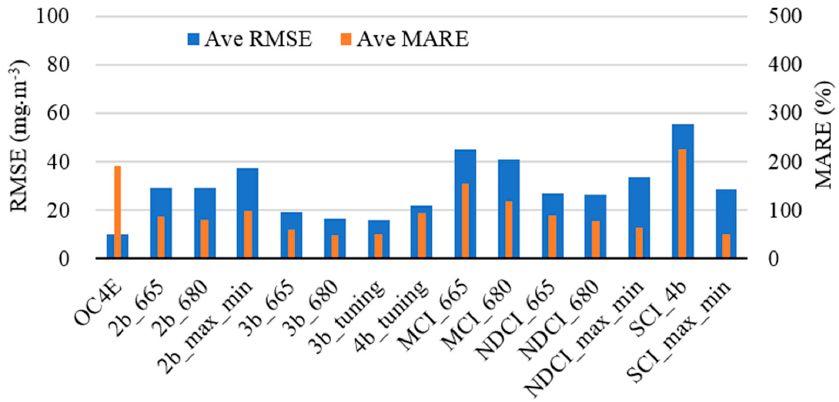
Figure 6. Overall assessment of the 15 algorithms in terms of root mean square error (RMSE) and mean absolute relative error (MARE) for simulated dataset. The values for RMSE and MARE were averaged for the three regression approaches of each algorithm (e.g., the RMSE of 2b_665_LN, 2b_665_QP, and 2b_665_PW were averaged as 2b_665).